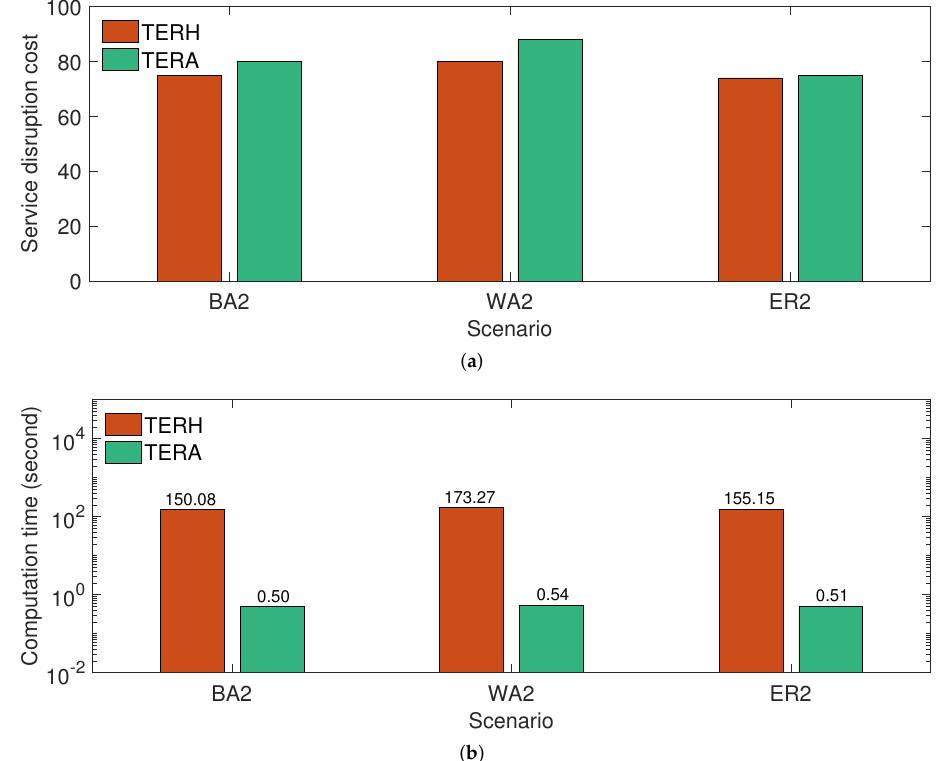
Figure 4. The TERA and TERH performance in a large-scale VCAV system. ( a ) Service disruption cost; ( b ) Computation